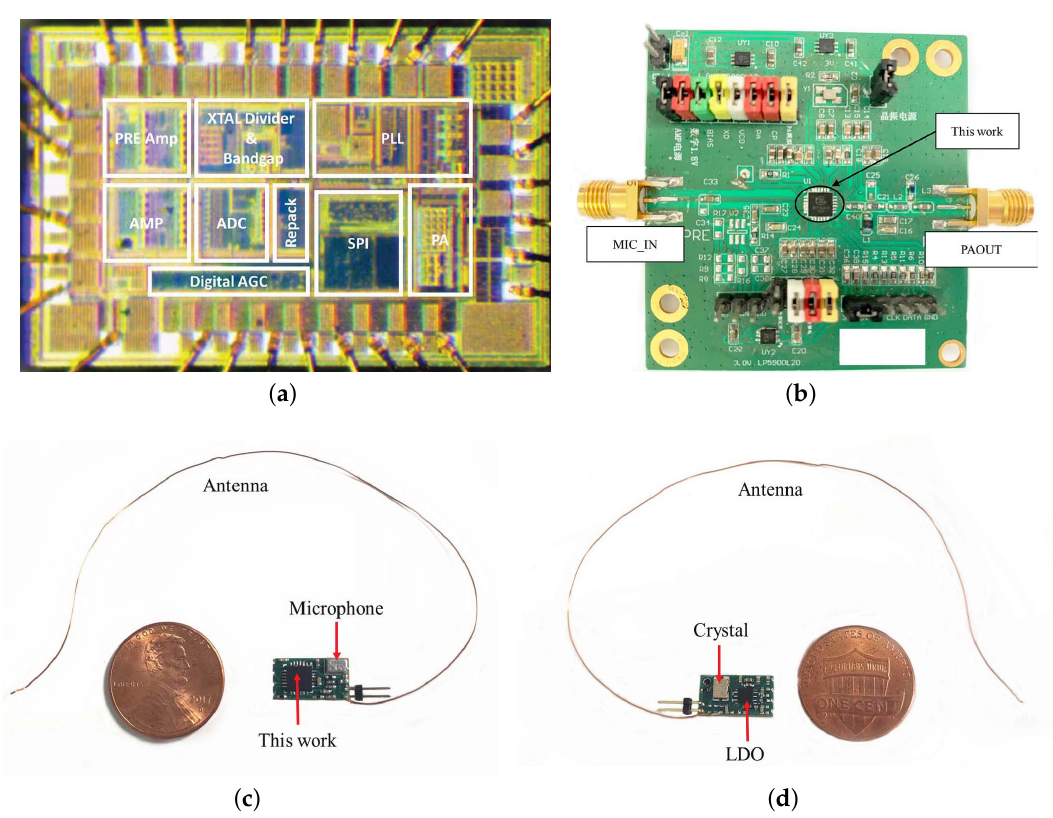
Figure 9. ( a ) Chip microphotograph; ( b ) testing board; ( c ) a demo compared with a coin (front); and ( d ) a demo compared with a coin (back).